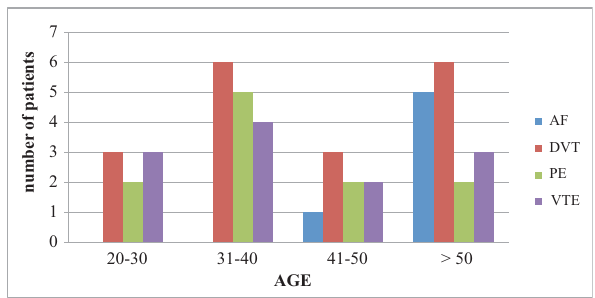
Fig. 1 Distribution of warfarin indications by age groups of